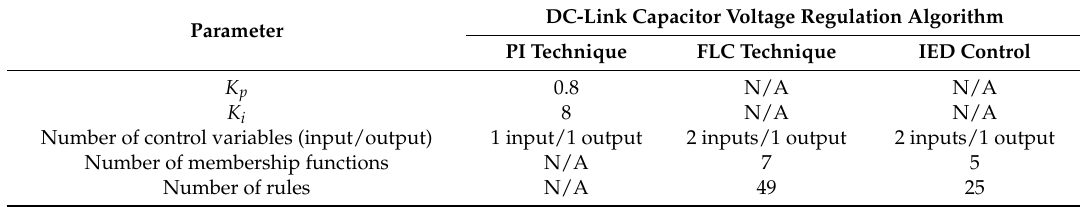
Table 4. Parameter specifications for each DC-link capacitor voltage regulation algorithm.